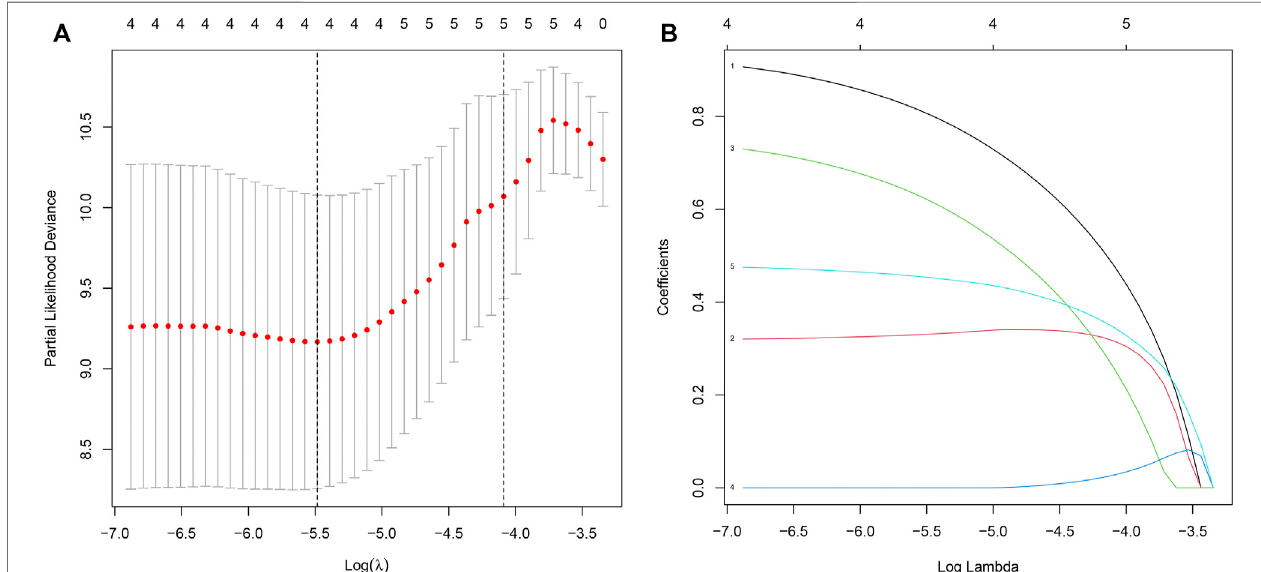
FIGURE 4 | Identi fi cation of IRDEGs associated with THCA prognosis. (A – B) LASSO coef fi cient pro fi les of prognostic-related IRDEGs. LASSO, least absolute shrinkage and selection operator. IRDEGs, immune-related differentially expressed genes.